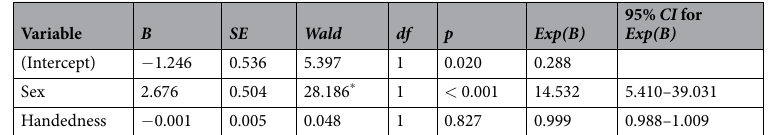
Table 1. Effects of sex and handedness on the initiation of kissing demonstrated through a binary logistic regression. Note. N = 96. Coding independent variable, Sex: Male = 1.000; Female = 0.000 (Reference category). Coding dependent variable, Initiation of kissing: No = 0; Yes =